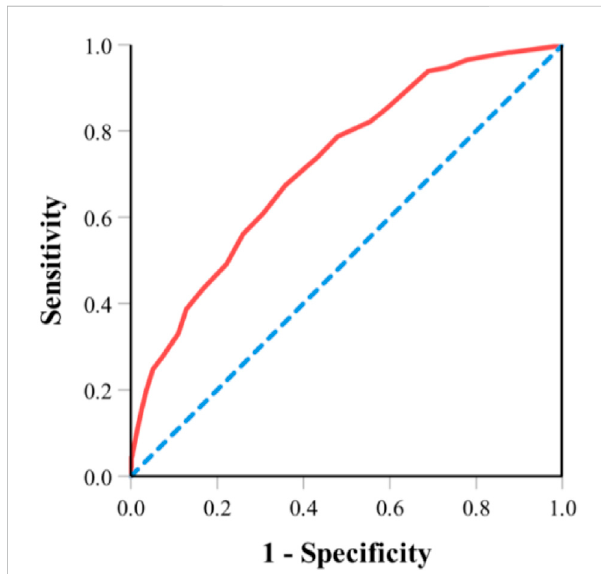
FIGURE 1 ROC curve for the predictive model. Note: Area under the ROC curve for the predictive model is 0.723 ([95% CI, 0.687 to 0.759]. ROC, receiver operating